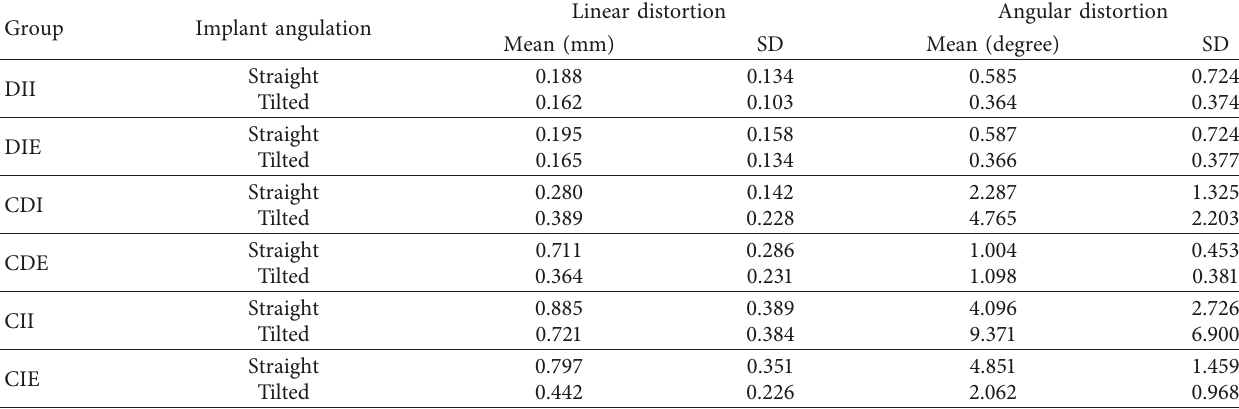
Table 2: Mean and SD values of three groups.